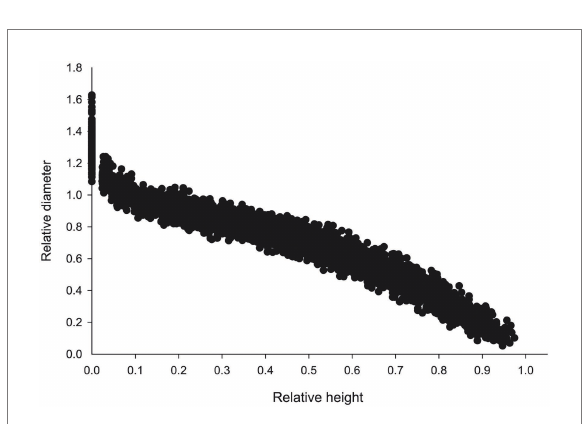
FIGURE 2 Relative height plotted against the relative diameter of the tree height of Larix principis-rupprechtii Mayr. Relative height, ratio of trunk height above ground to total tree height; relative diameter, ratio of diameter to DBH at the height of trunk above the ground.